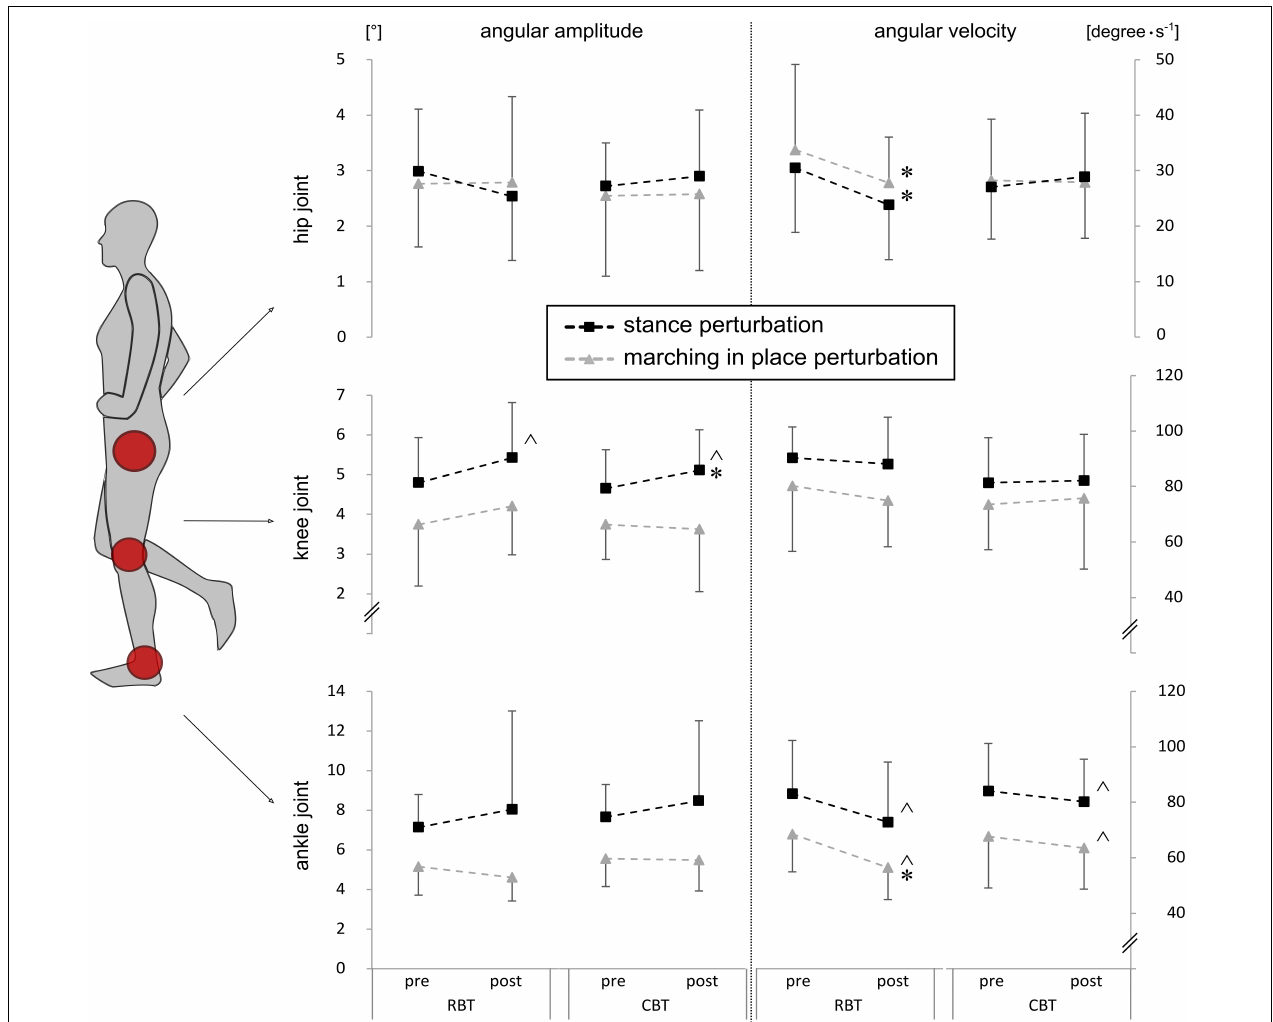
FIGURE 4 | Kinematic data of lower limb joints. Joint kinematics, such as amplitude [ ◦ ] (left column) and velocity (degrees · s − 1 ) (right column), for the ankle, knee, and hip joint during stance perturbation (black rectangles, protocol 1 ) and marching in place perturbation (gray triangles, protocol 2 ) are shown. Mean values are illustrated for both training groups – the RBT group and the CBT group. Significant time effects are marked with ˆ ( P < 0.05) and significant group comparisons (TTESTs) with ∗ ( P t <